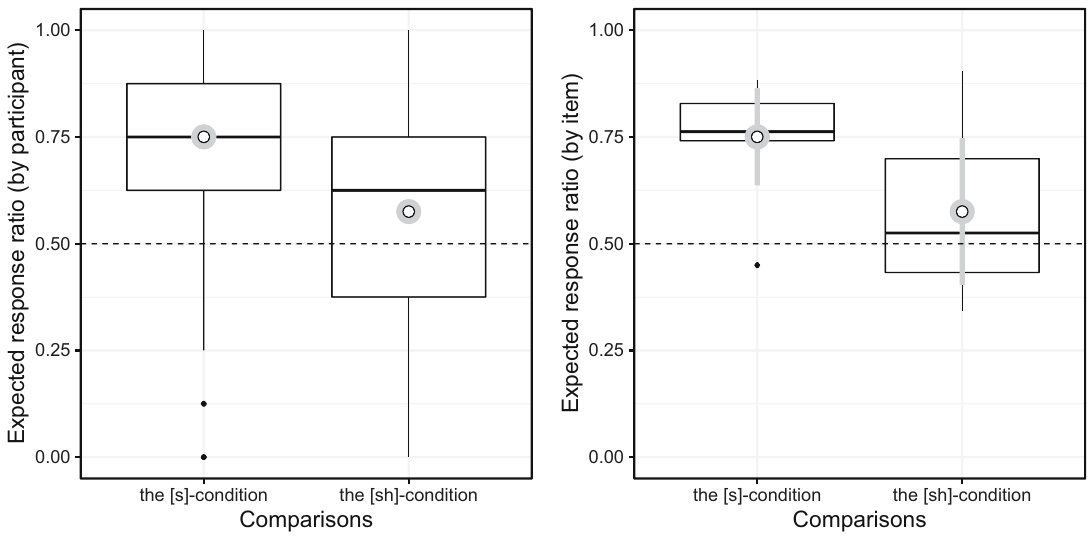
Figure 3: Box plots illustrating the distributions of expected response ratios ( the large data set ) . Left = by participant; right = by item. The 95% con fi dence intervals of the left fi gure ( the by - participant analysis ) are tiny due to large N (= 776 ) .